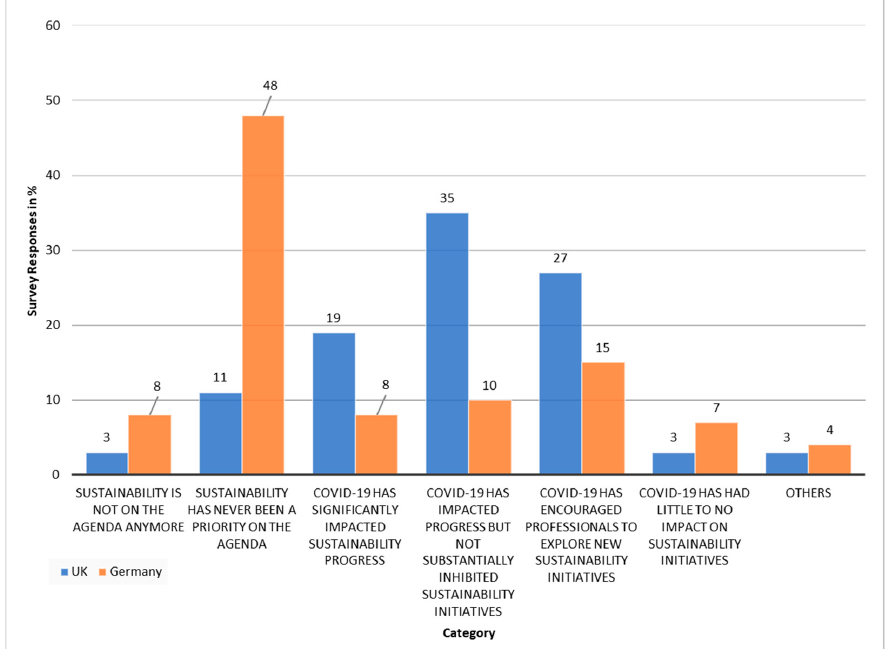
Figure 4. Comparison of UK and Germanys survey responses about the impact of COVID-19 on sustainability in health care. sustainability in health